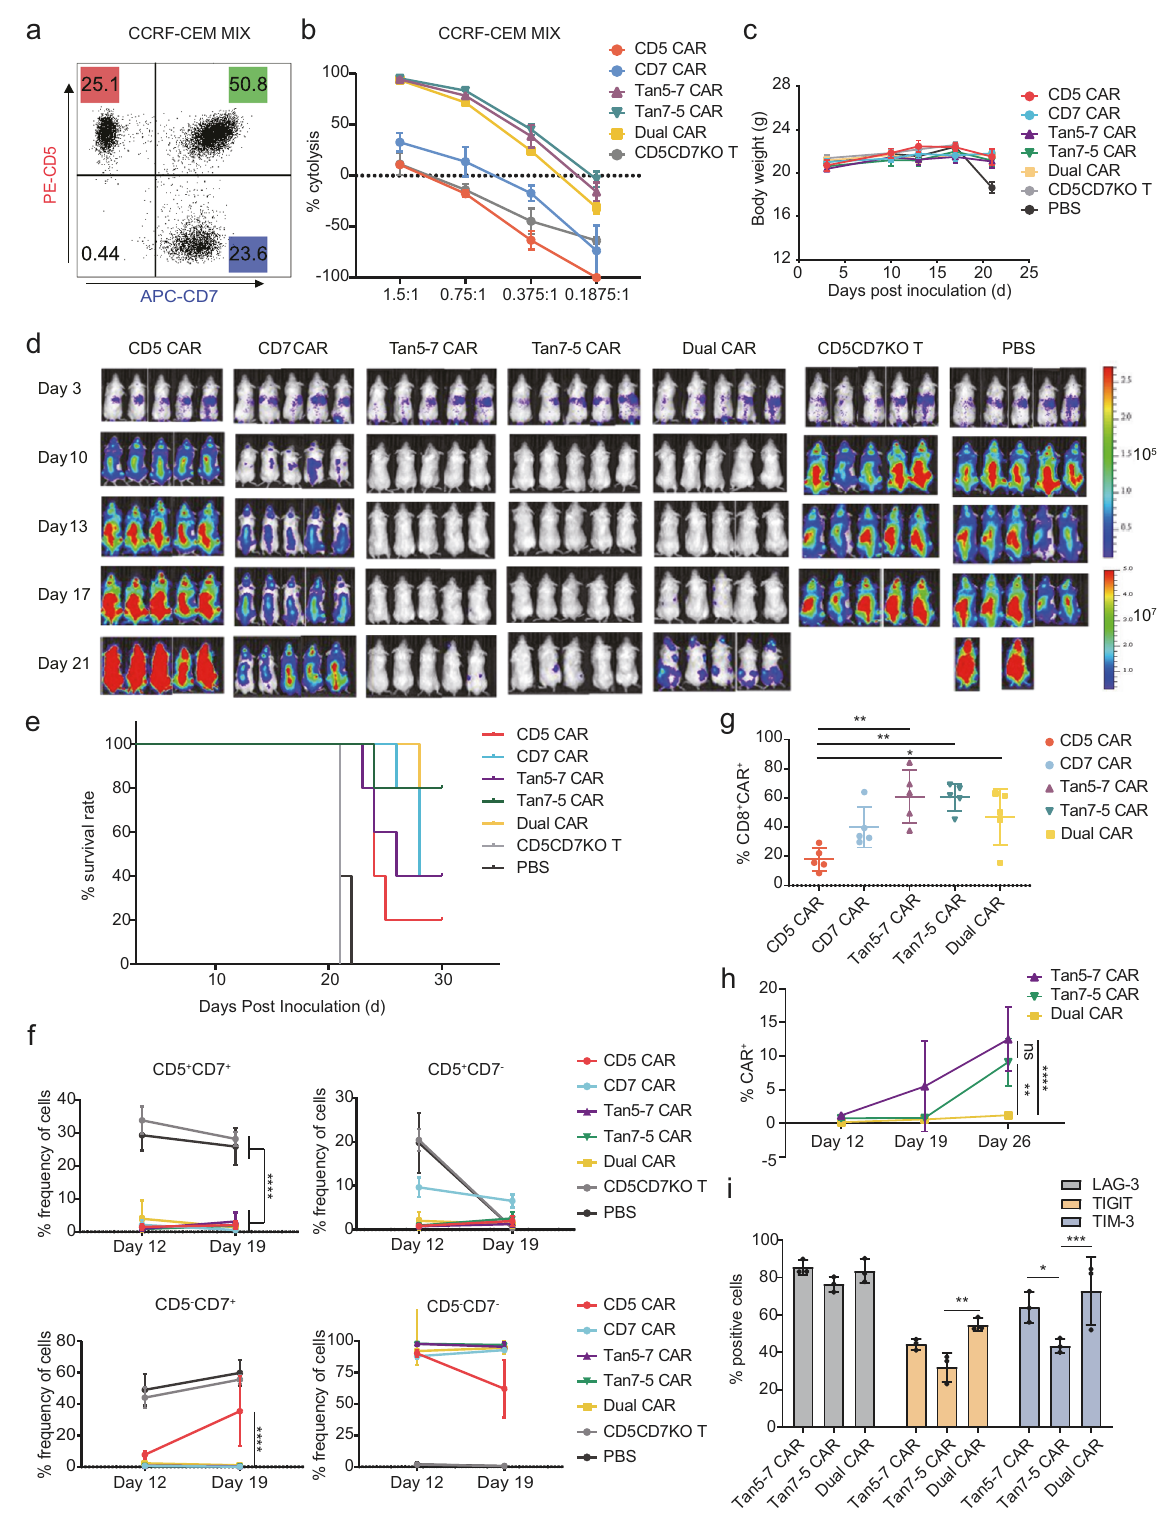
preclinical studies of FH single-domain antibody-derived CAR-T therapies showed similar in vitro and in vivo functions to those of murine scFv-derived benchmarks, such as CD33-targeting V H (CAR33V H ) and B-cell maturation antigen (BCMA)-targeting V H (FHV H 33), 44,45 and bispeci fi c FHV H -derived CAR-T therapy